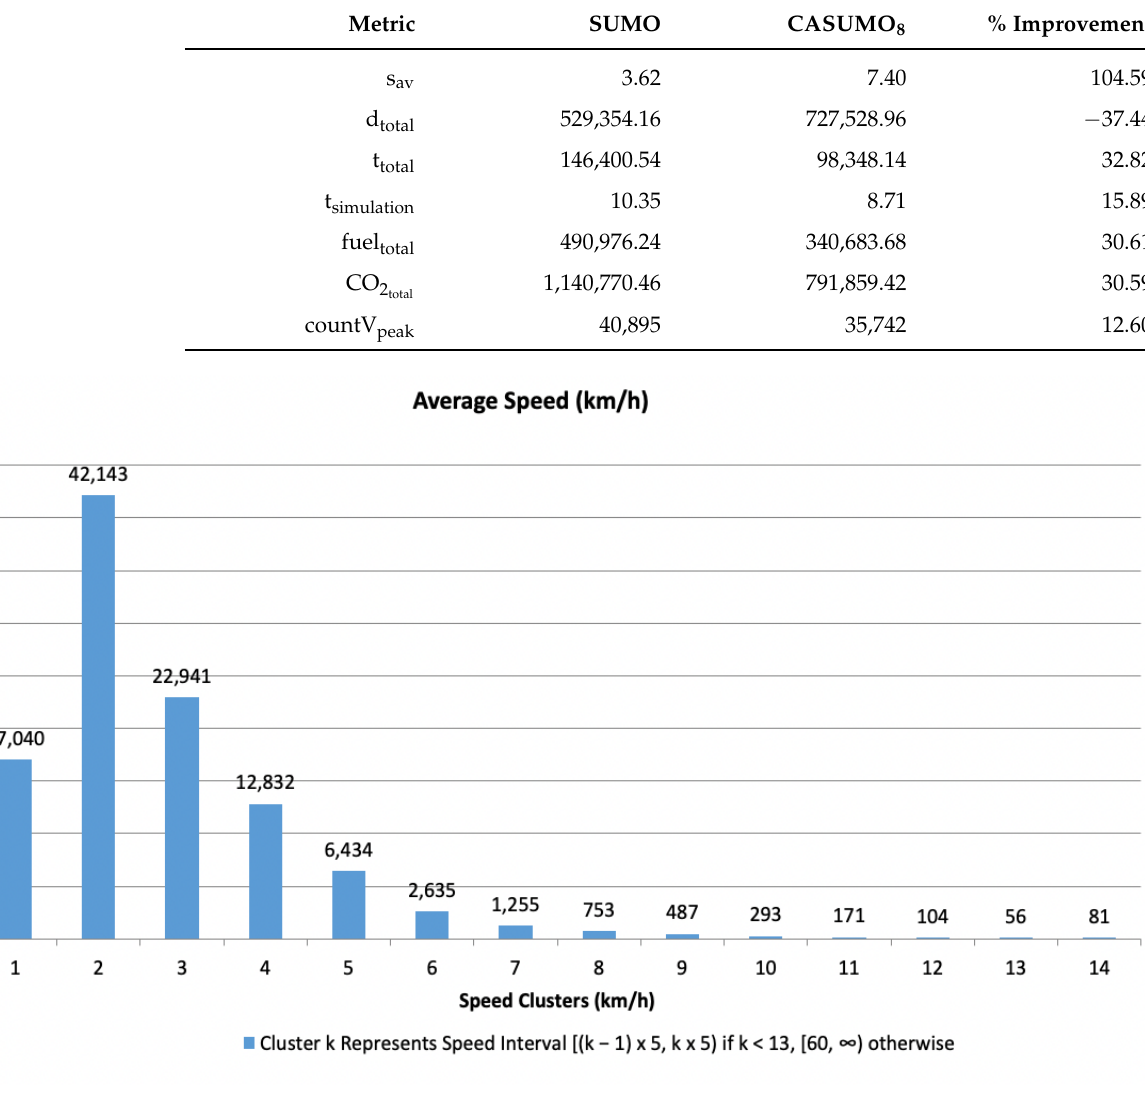
Table 13. Results and improvement of the proposed solution for 100 K+ simulated vehicles in Tokyo.